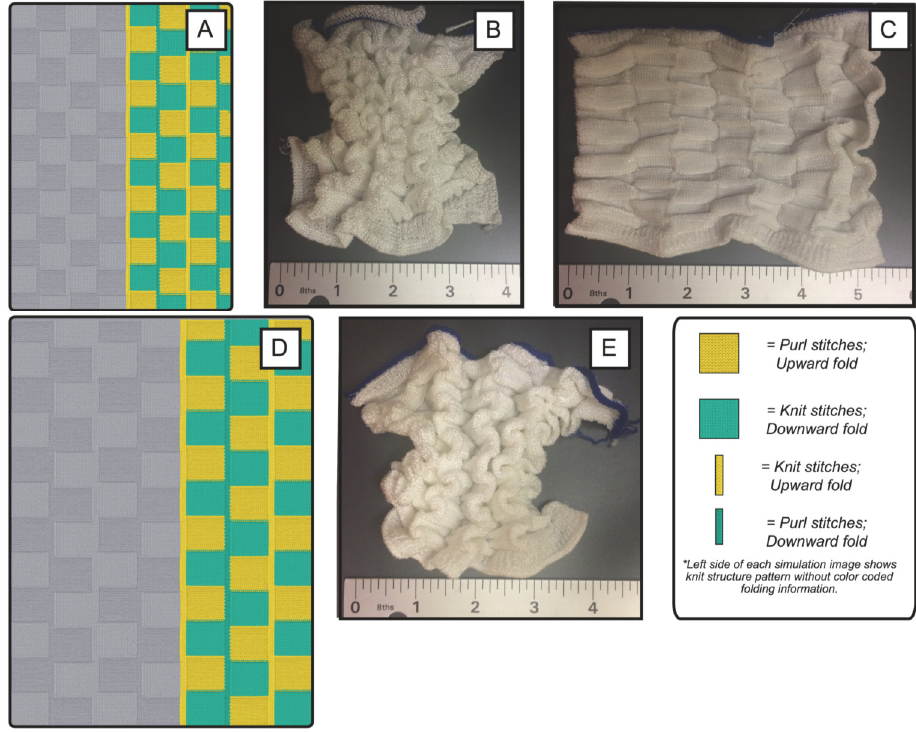
Figure 3. Mapping of folding patterns. ( A ) Computer simulation of original pattern; ( B ) original pattern knit with polyester yarn; ( C ) original pattern knit with polyester and spandex yarns; ( D ) computer simulation of readjusted pattern; ( E ) readjusted pattern